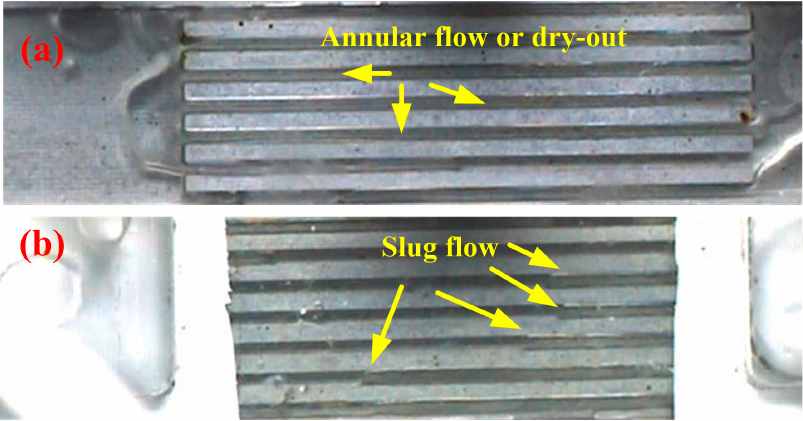
Figure 12. Effect of vapor venting membrane on the flow regime: ( a ) Without membrane; ( b ) With membrane.